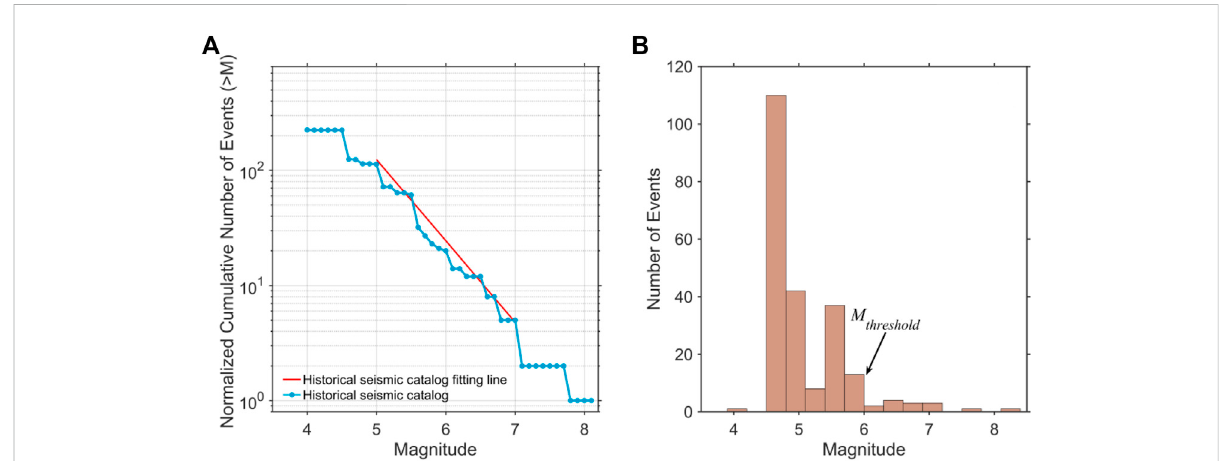
FIGURE 11 (A) TheG-RmagnitudefrequencyrelationofhistoricalearthquakesintheFWRZ. (B) Frequencyasafunctionofmagnitudecorrespondingtothe historical earthquake catalog in (A) . M threshold represents the magnitude threshold of long-term shallow earthquakes for calculating the long-term seismicity in the FWRZ. The historical earthquakes data are after the National Earthquake Data Center (http://data.earthquake.cn).